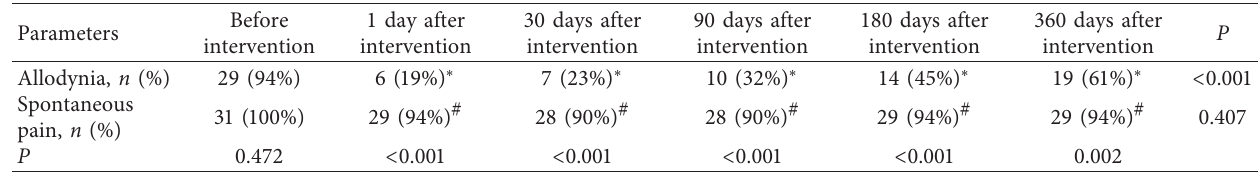
Table 3: Comparison of the number of patients with allodynia and spontaneous